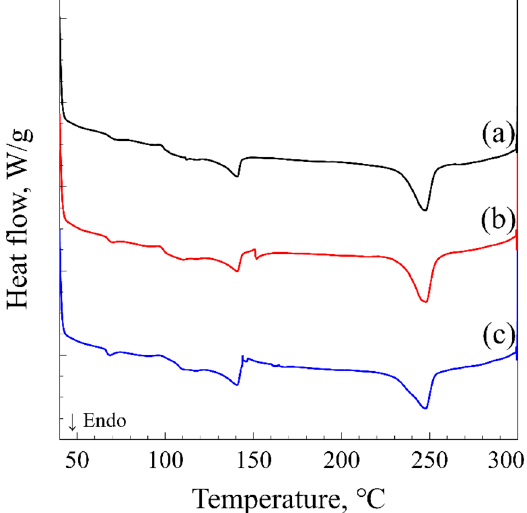
Figure 3. Differential scanning calorimetry (DSC) thermogram of ( a ) unprocessed ABS/R-PET blend, ( b ) ABS/R-PET blend after sorption process, and ( c ) ABS/R-PET blend foamed at 60 °C. The